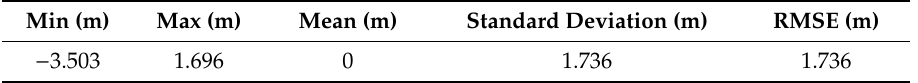
Table 5. Statistical values of the residuals for the East coordinates resulting from datum transformation UTM / ED50 to UTM / WGS84 based on a simplified approach (translation).